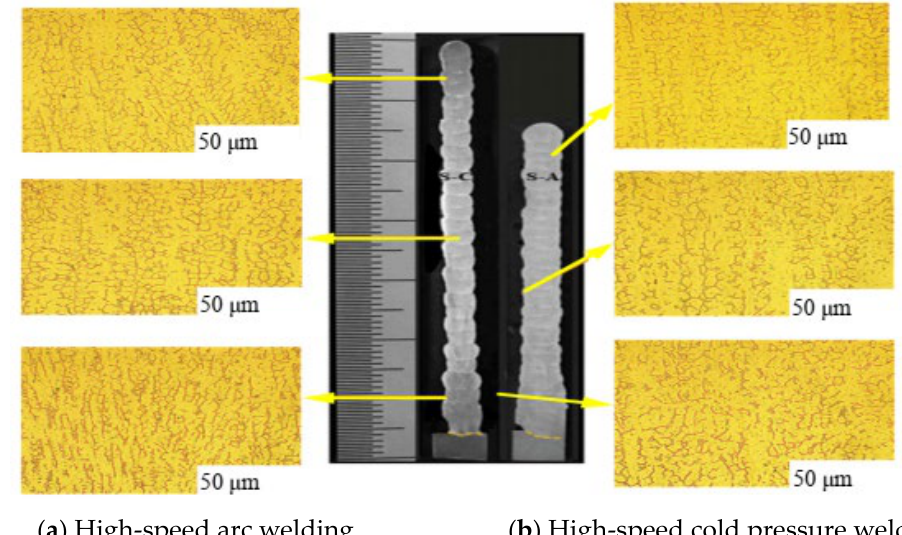
Figure 7. Microscopic view of two welding methods.